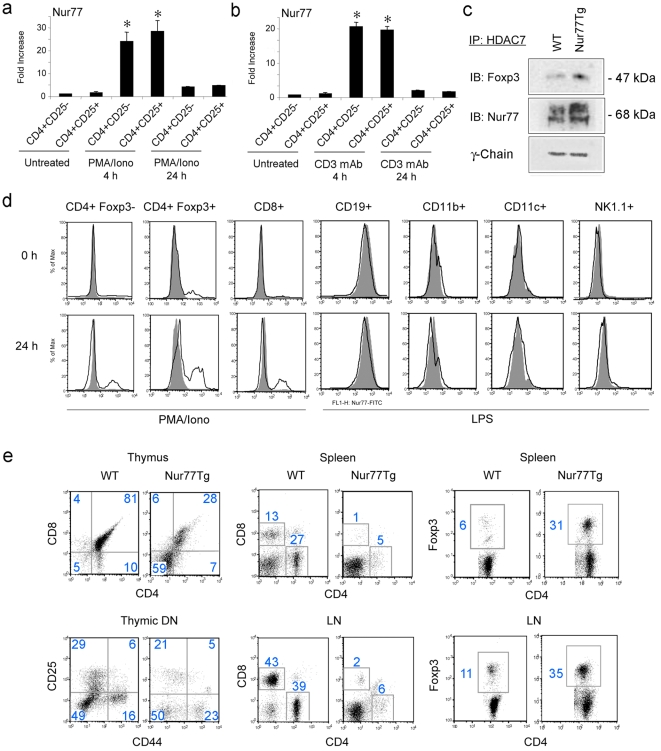
Nur77 expression by thymocytes and peripheral T cells in WT and Nur77Tg mice.(a) Nur77 mRNA expression after T cell activation using PMA/ionomycin or (b) CD3 mAb as shown by qPCR analysis of CD4+CD25− and CD4+CD25+ T cells; data expressed as fold increases (mean±SD) above control set as 1. Nur77 expression at 4 h was comparable (p>0.05) for Tregs and non-Tregs, but significantly increased compared to levels either at rest or after 24 h of activation (*p<0.01). (c) Nur77 forms a complex with HDAC7 and Foxp3 as shown by immunoprecipitation of HDAC7 from splenocytes, followed by SDS-PAGE and Western blotting with mAb to Foxp3 or Nur77. (d) Nur77 is mainly expressed by T cells upon activation, especially by CD4+Foxp3+ Tregs, as shown by splenocytes stimulated with PMA/ionomycin or LPS for 24 h, followed by staining with cell markers, and mAbs to Foxp3 and Nur77, or isotype controls (grey). Data are representative of 2 experiments with similar results. (e) Altered thymocyte development, decreased peripheral T cell populations and expanded proportion of CD4+Foxp3+ fraction in Nur77Tg mice. Thymuses from WT or Nurr77Tg mice were stained with CD4, CD8, CD25 and CD44 Abs; left upper panel showed the proportions of single positive (CD4+ or CD8+), double positive and double negative cells, and left lower panel shows analysis of the double negative (DN) population 1–4 based on CD44 and CD25 expression. Cells were also isolated from spleens and lymph nodes of WT or Nur77Tg mice and stained with CD4 and CD8 Abs, followed by intranuclear staining for Foxp3. Figure in each square indicates the percentage of labeled cells, and data are representative of results from 8 mice per group.